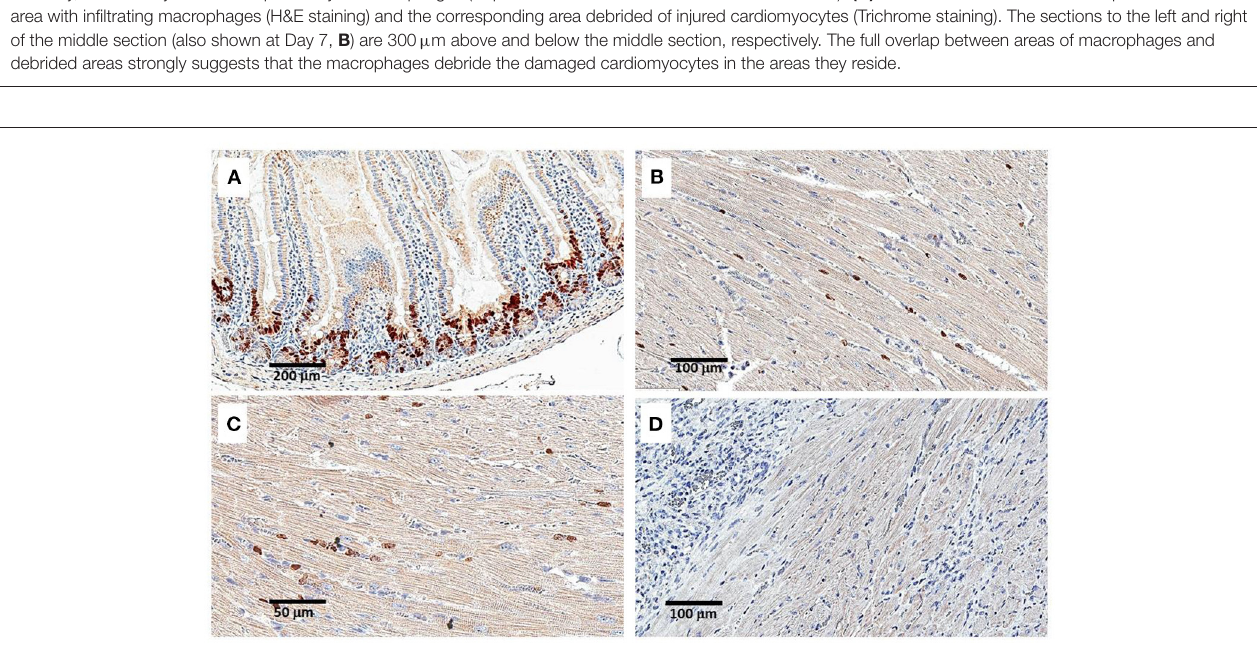
FIGURE 6 | Staining for BrdU uptake by proliferating cells, 24h following intraperitoneal injection of 1mg BrdU. Injection was performed on Day 9 post-MI and intramyocardial α -gal nanoparticles injection. (A) Intestinal villi demonstrating effective uptake of BrdU in proliferating cells at the base of the villi (serving as a positive control). (B–D) Staining of the LV for BrdU uptake in an α -gal nanoparticles treated mouse. Only sparse uptake is observed. In (D) the section displays an area of macrophage infiltration near the cardiomyocytes. Data from one mouse of 5 with similar